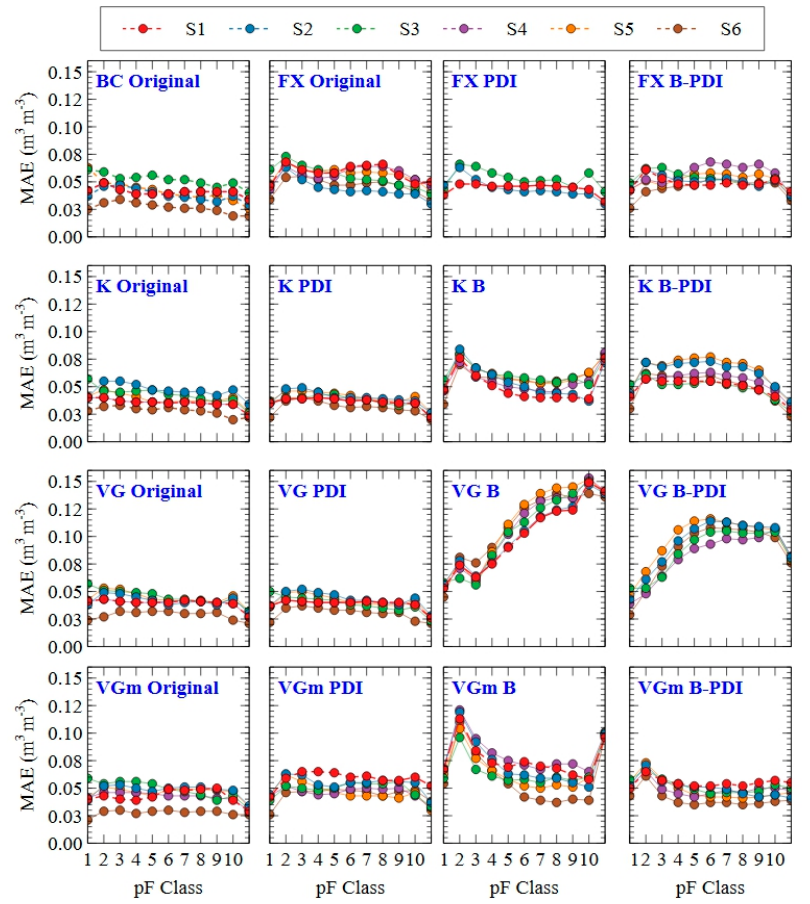
Figure 5. Performance of the 16 models across tension classes and the six modeling scenarios (S1–S6). BC: Brooks and Corey [34], FX: Fredlund and Xing [35], K: Kosugi [36], VG and VGm: van Genuchten [24] constrained and unconstrained unimodal models. PDI and b denote Peters–Durner–Iden [30,31] and bimodal variants of the models, respectively. pF classes (cm of water): C1 ( < 100), C2 (100–200), C3 (200–300), C4 (300–400), C5 (400–500), C6 (500–600), C7 (600–700), C8 (700–800), C9 (800–900), C10 (900–1000) and C11 ( > 1000). MBE: mean bias error (cm 3 cm − 3